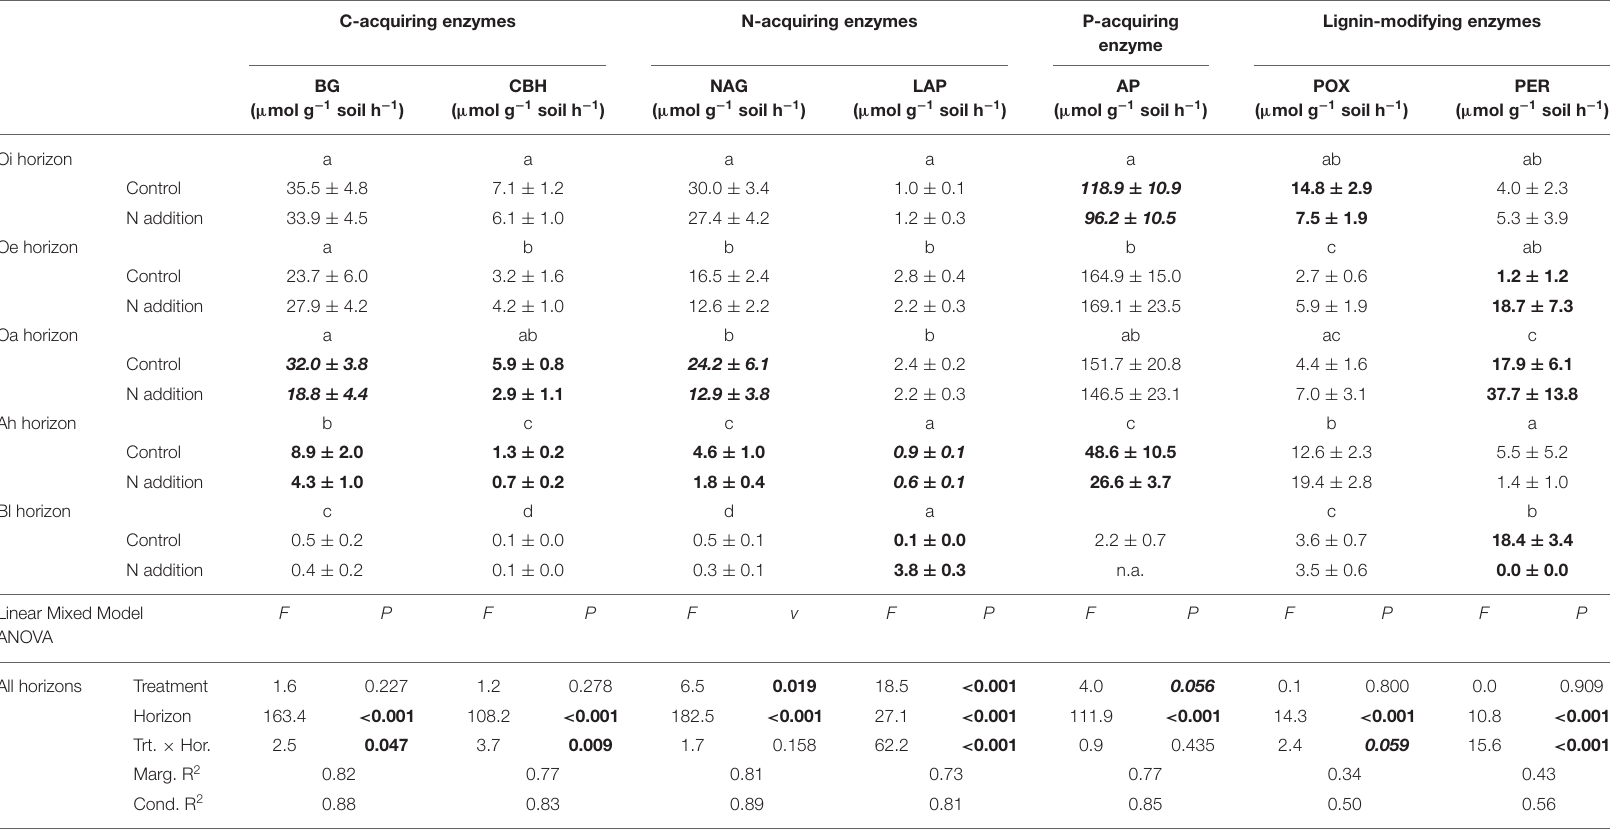
TABLE 5 | Activities of seven soil enzyme classes involved in organic matter decomposition in response to long-term N addition at Alptal